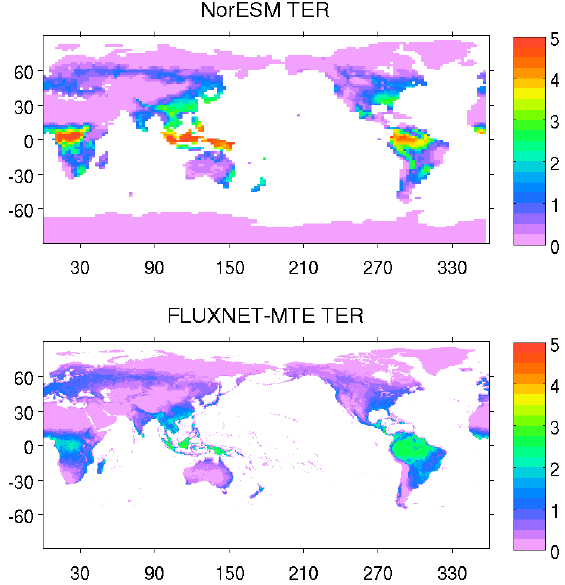
Fig. 19. Same as Fig. 18 for terrestrial ecosystem respira- tion (i.e., sum of autotrophic and heterotrophic). Units are in (kgCm − 2 yr − 1 ).